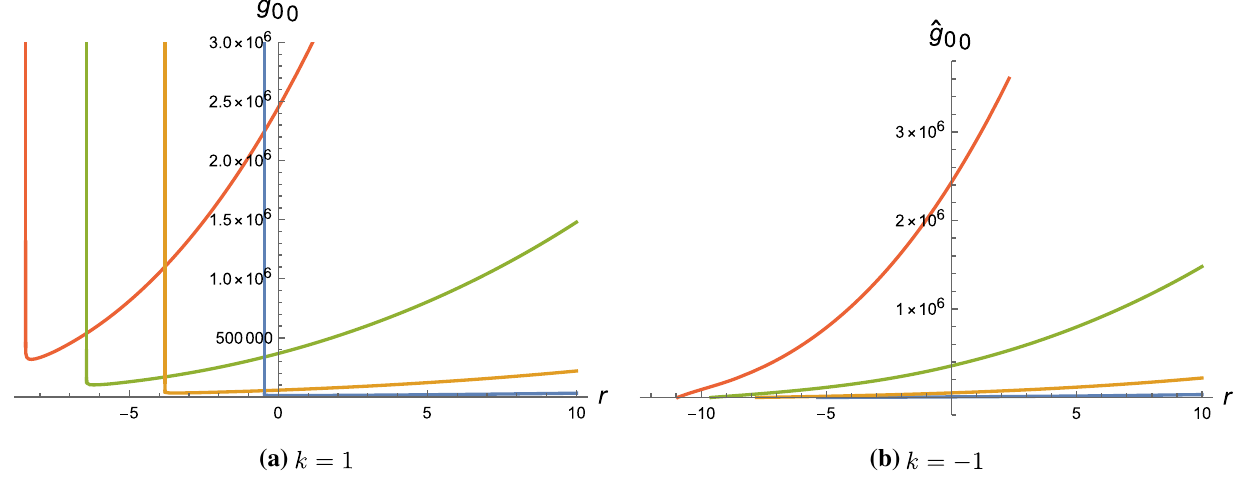
Fig. 47 Profiles of the ten-dimensional metric component ˆ g 00 for the supersymmetric flows given in Figs. 45 and